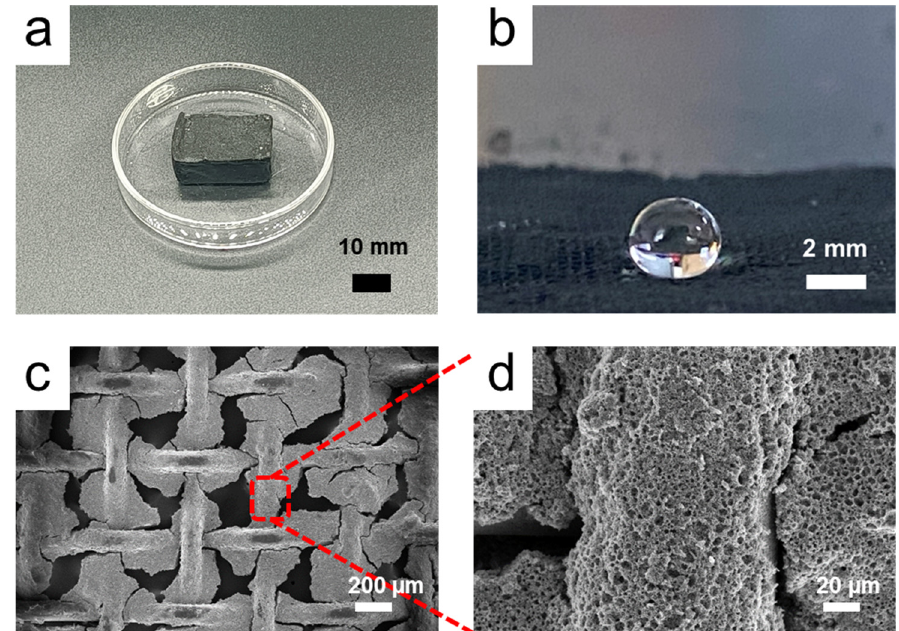
Figure 2. Characterization of morphology and wettability of the graphite-coated copper foam. ( a ) Photograph of the prepared composite PCM. ( b ) Photograph of a water droplet on the graphite-coated copper foam. ( c , d ) SEM images at different magnifications of the graphite-coated copper foam.